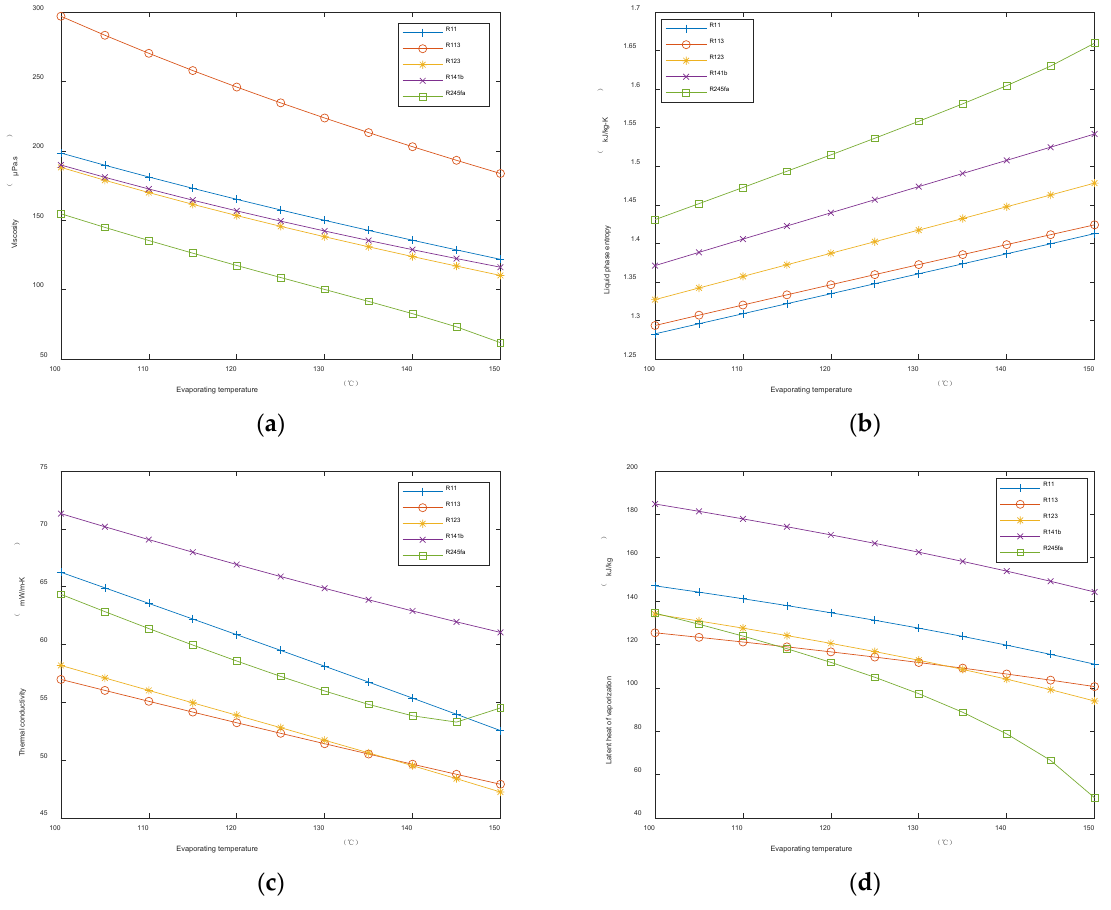
Figure 6. Physical properties of the organic working medium. ( a ) Variation of viscosity of different organic working fluids with evaporation temperature; ( b ) Variation of liquid entropy of different organic working fluids with evaporation temperature; ( c ) The variation of thermal conductivity of different organic working fluids with evaporation temperature; ( d ) Variation of latent heat of vaporization of different organic working fluids with evaporation temperature.